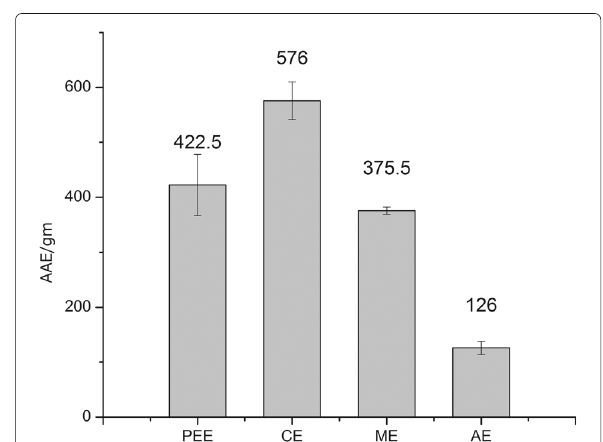
Fig. 4 Total antioxidant activity of extracts of C.pallida stem. All tests were done three times. PEE-Petroleum ether extract, CE- Chloroform extract, ME-Methanol extract, AE-Aqueous